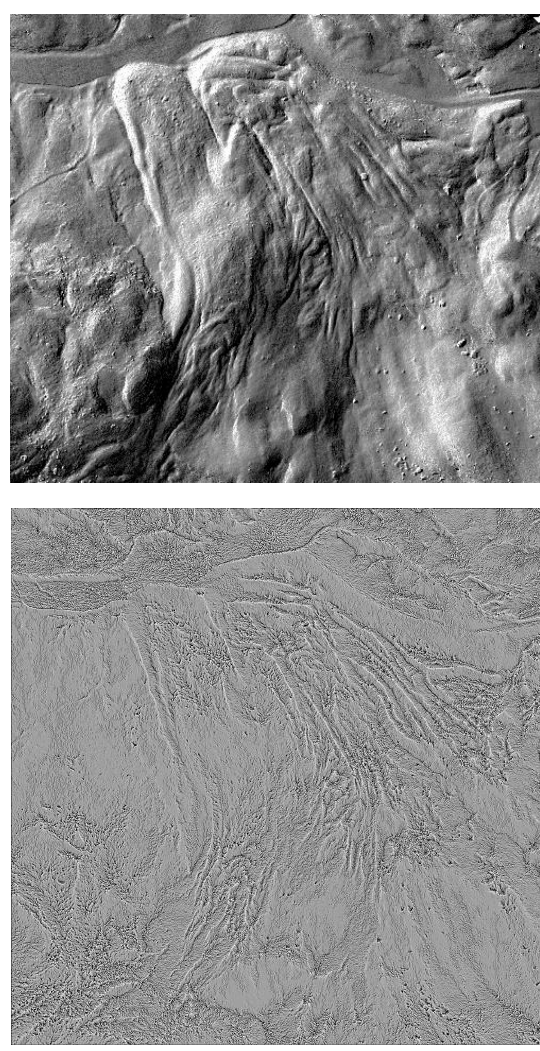
Figure 6. Top : Shaded DSM of the October 2012 flight. Bottom : Elevation raster map, after the Wallis filter application, of the October 2012